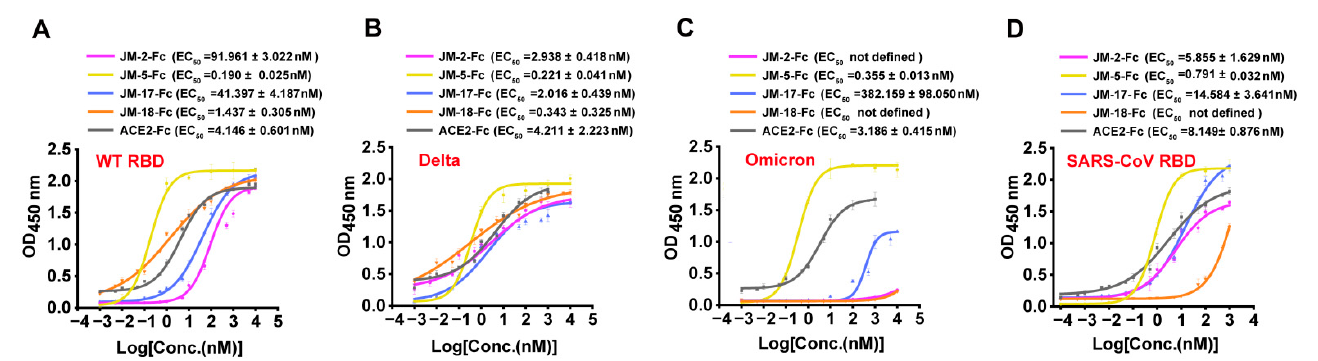
Figure 3. Binding characterization of identified VNARs and ACE2 to various RBD by ELISA. ( A – D ) VNAR-Fc fusions binding to RBD of WT ( A ), Delta ( B ), Omicron ( C ), and SARS-CoV ( D ) were characterized using ELISA. Error bars indicate means ± the SD from three independent experiments. The EC 50 was calculated by fitting the OD 450 values from serially diluted VNAR-Fc fusions or ACE2-Fc to a sigmoidal dose–response curve.